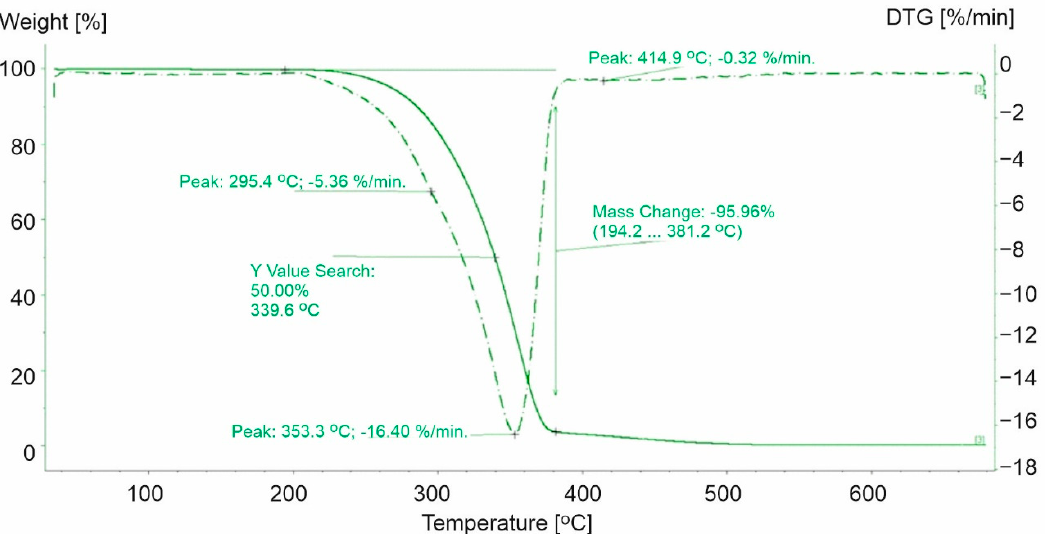
Figure 3. TG and DTG curves for PP ‐ 3. The green line presents TG curve, while the green dot line presents DTG curve.